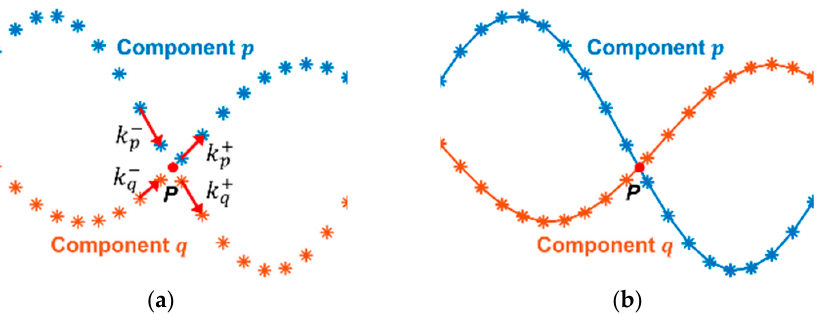
Figure 12. Schematic of post-processing. ( a ) Extracted components and cross points. ( b ) Regrouped and interpolated components.